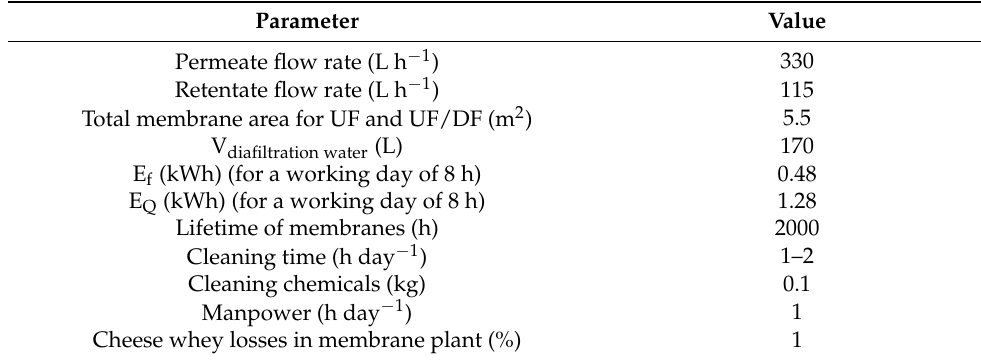
Table 4. Technical parameters of UF/DF membrane plant for q f = 450 L h − 1 of GCW or